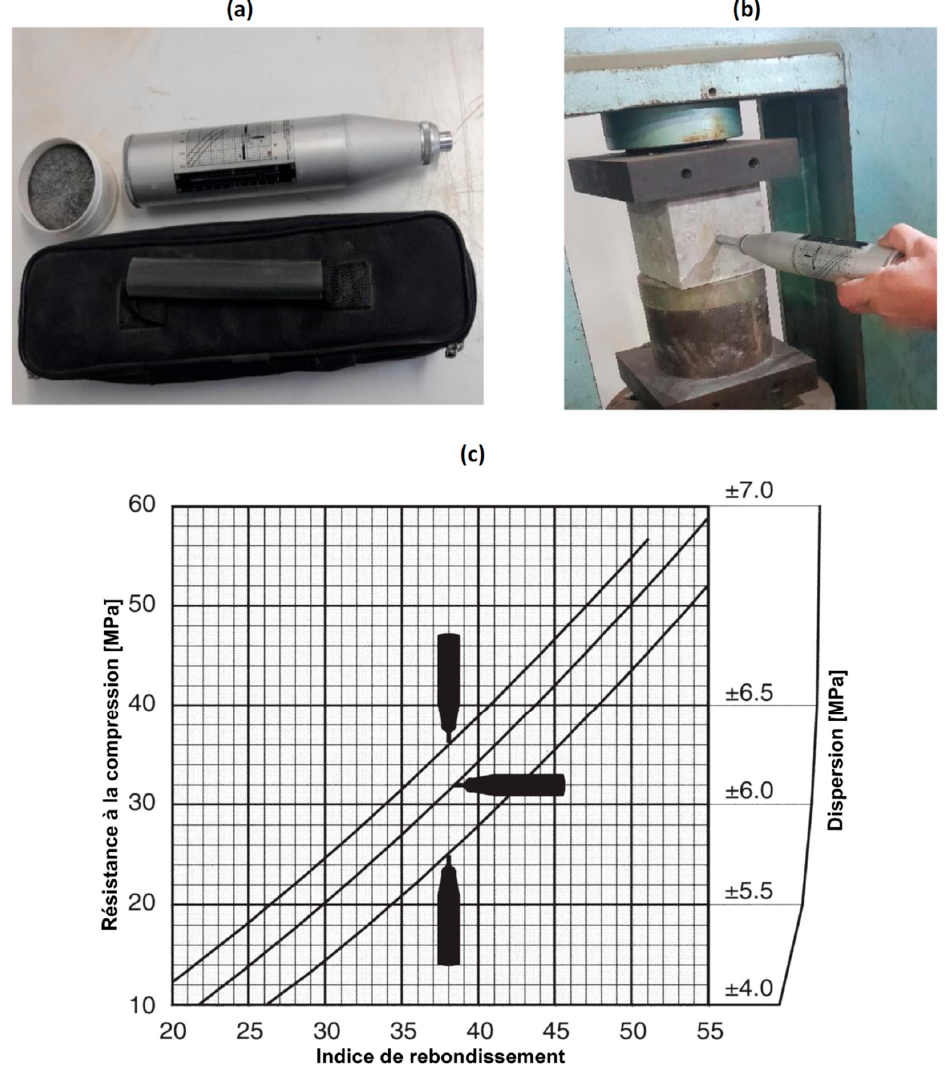
Figure 4. Schmidt rebound hammer test. ( a ) Schmidt rebound hammer. ( b ) Carborundum stone. ( c ) Chart for determining the compressive strength as a function of RN.